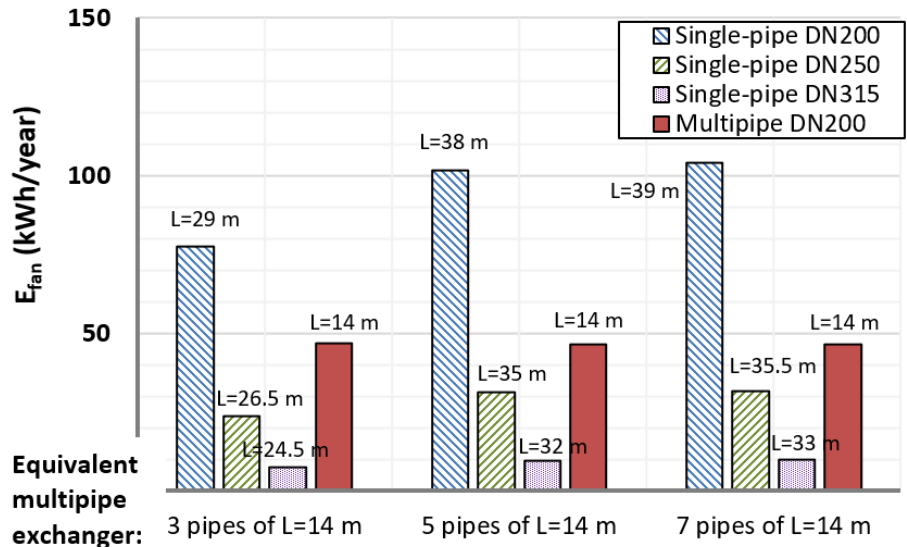
Figure 11. Full-year energy usage for driving the fans for multipipe structures of length L = 14 m and single-pipe structures of equivalent length in the context of heating capacity with different pipe diameters: d = DN200, DN250 or DN315, V = 600 m 3 /h.